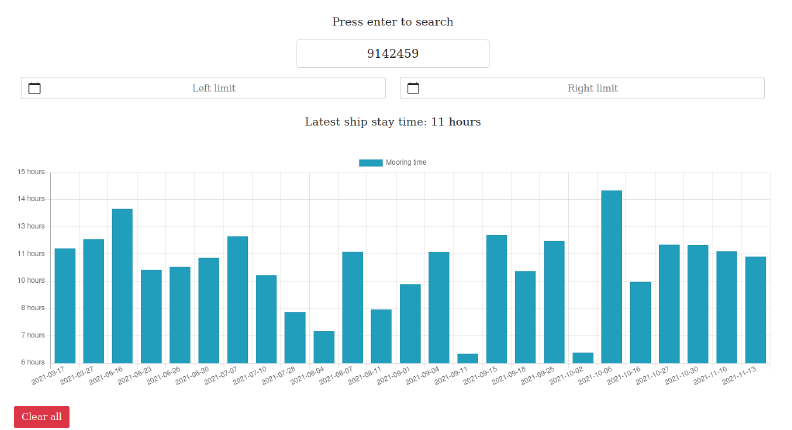
Figure 9. Ship Stay Time Web Interface.